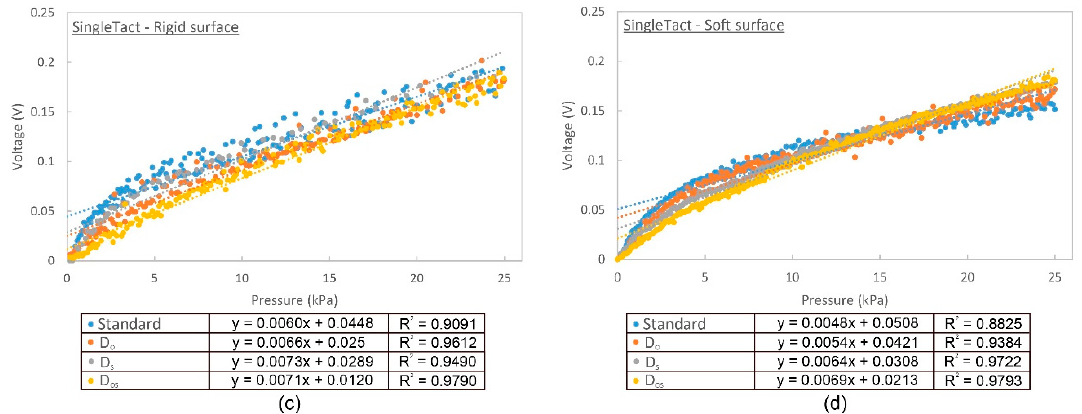
Figure 6. X-axis corresponds to applied pressure converted from force gauge reading. Y-axis corresponds to sensor reading in voltage. ( a ) FlexiForce sensor calibration curve on rigid surface, ( b ) FlexiForce sensor calibration curve on soft surface (silicone of 30 Shore OO hardness), ( c ) SingleTact sensor calibration curve on rigid surface, ( d ) SingleTact sensor calibration curve on soft surface (silicone of 30 Shore OO hardness).